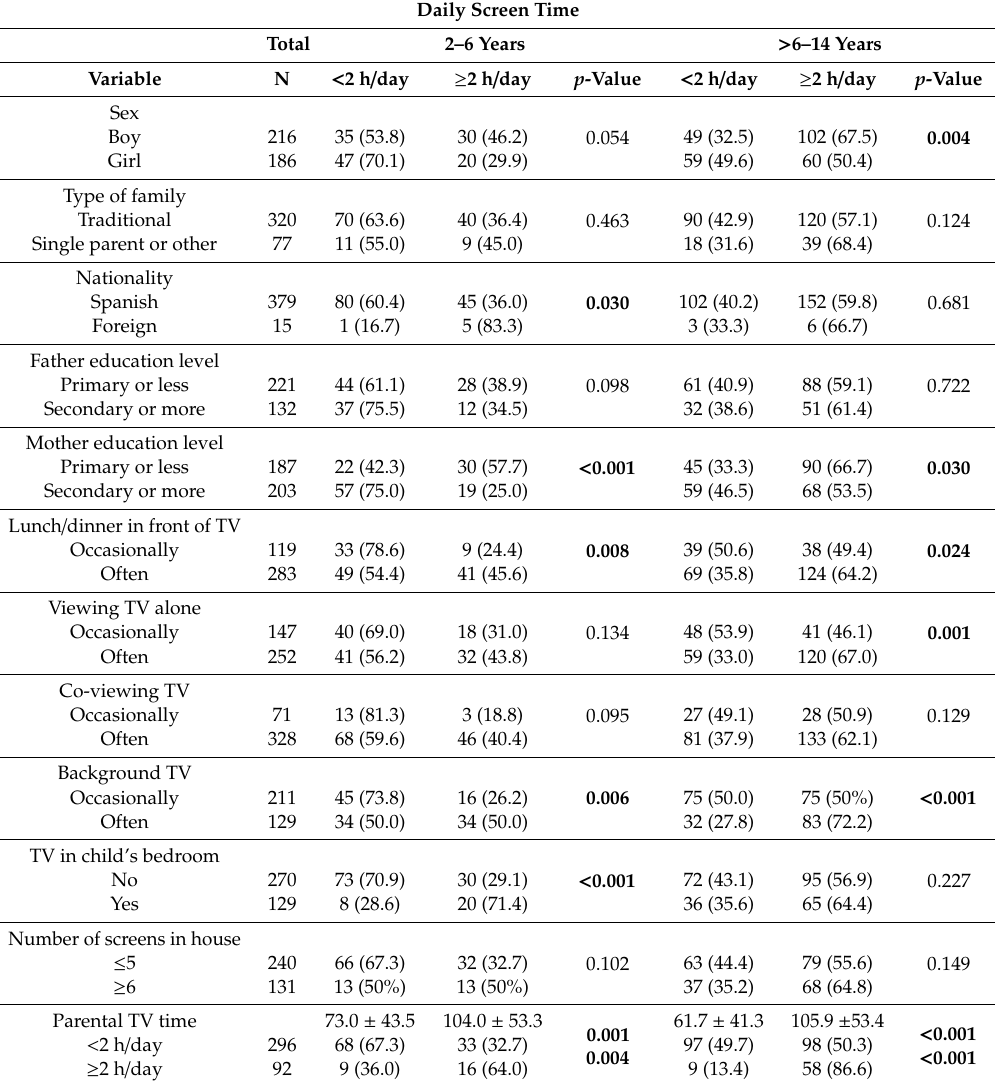
Table 1. Association of di ff erent variables with recreational screen time (more or less than 2 h) in two age groups of